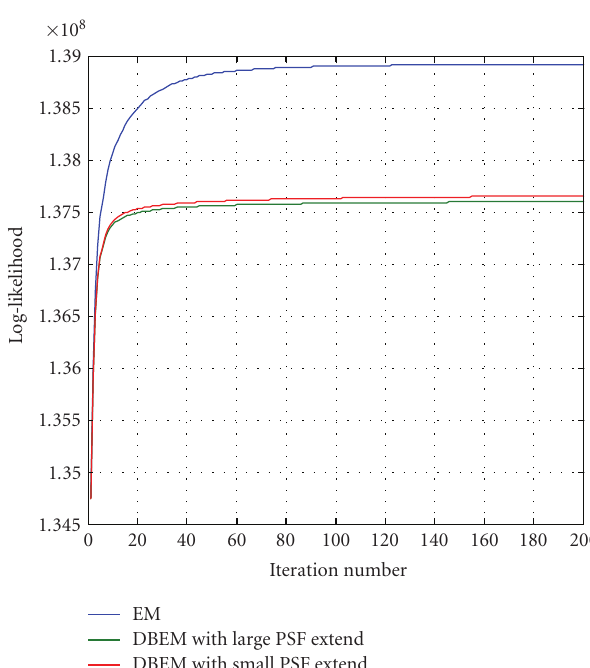
Figure 3: Log-likelihood of EM and BDEM algorithms as a function of iteration number. The two BDEM plots have di ff erent PSF extend constraints; small PSF extend limits the PSF to 10 × 10, whereas large extend limits the PSF to 20 × 20. The image size is 128 × 128 pixels.